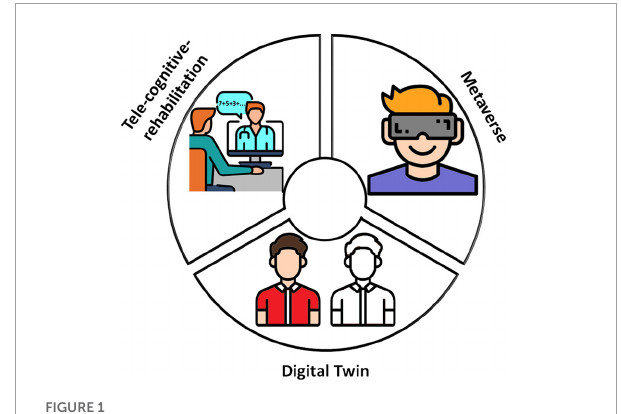
FIGURE1 The three digital ingredients. Digital twin, tele-cognitive-rehabilitation, and metaverse are digital ingredients that can improve per se cognitive rehabilitation outcomes in MS. In the beginning, data from tele-cognitive-assessment with dedicated apps implementing validated cognitive tests would allow the cognitive phenotyping of PwMS at group-level; over time, based on an increasing amount of data the AI algorithms would provide a rough cognitive virtual patient’s copy. Asynchronous and, especially, synchronous remote interventions can be delivered through tele-cognitive-rehabilitation; the availability of digital tools for remote communication allowed overcoming barriers that limit the CR access to many PwMS and, consequently, starting the treatments as soon as possible and continuing them during the different disease phases. Metaverse makes available virtual scenarios in which PwMS can actually train in ecological environments a plethora of dual- and multi-tasks and everyday life activities. This figure has been designed using modified free images